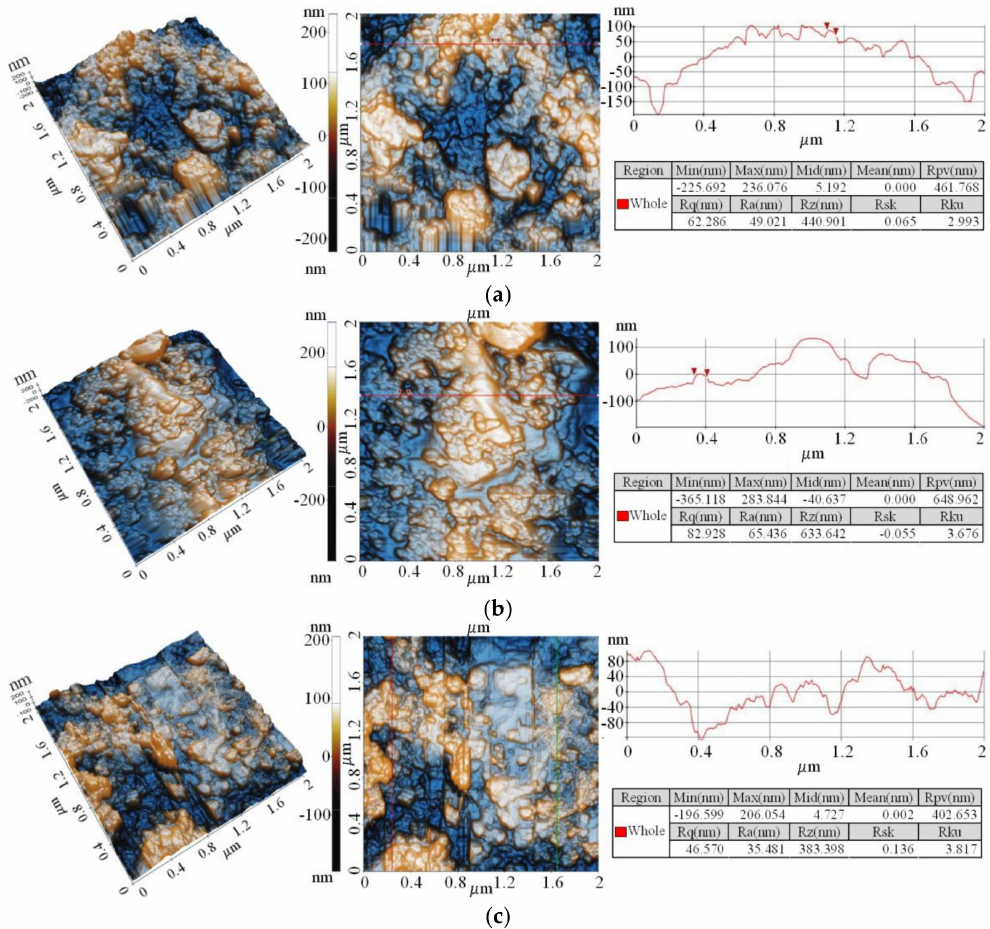
Figure 4. Atomic force microscopy (AFM) images of the photocatalytic coating containing 10 wt % P25-Fe(III)PcTC ( a ) before and ( b ) after exposure to LED light for 156 h; and ( c ) to Xenon light for 72